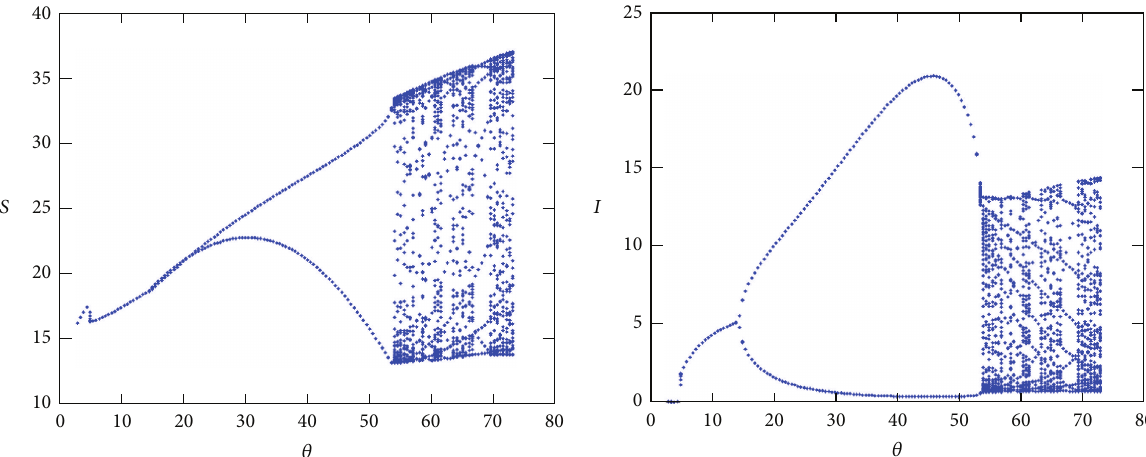
Figure 2: Bifurcation diagrams of system (8) with respect to 𝜃 in case (1) of Section